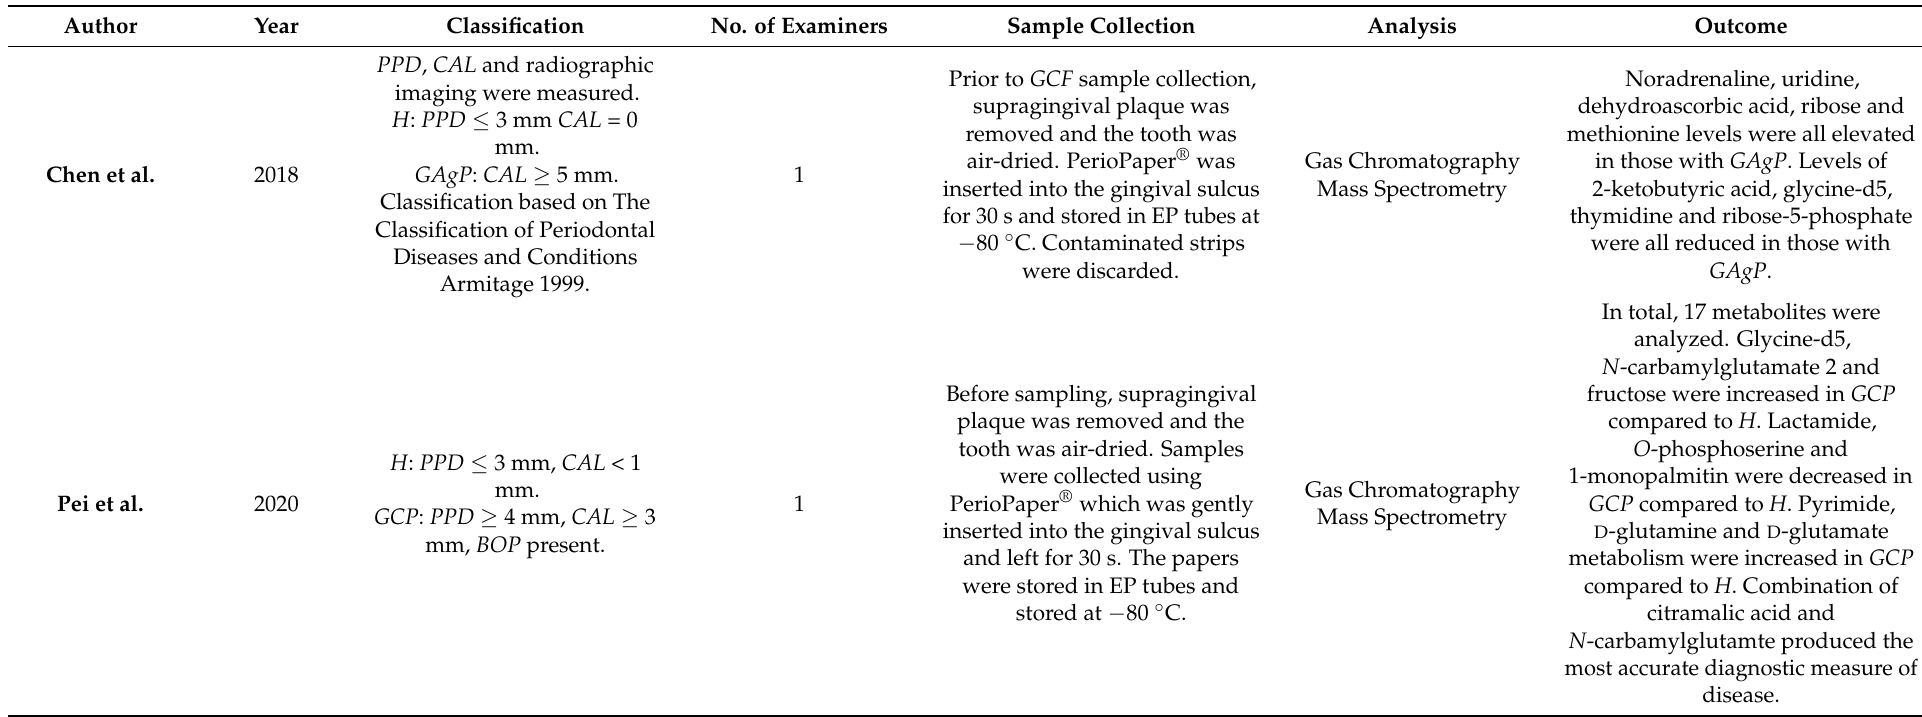
Table 8. Disease classification, number of examiners, sample collection method, sample analysis technique and brief outcome of studies analyzing metabolite-based